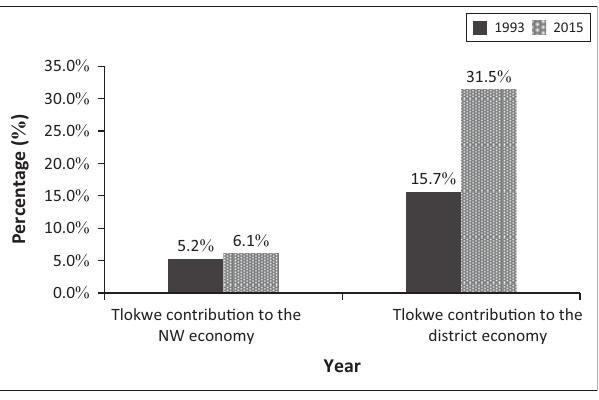
FIGURE 3: Tlokwe economy contribution to North West Province and district gross value-added (GVA), 1995 and 2013, constant 2010